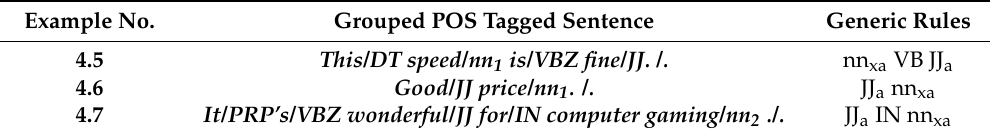
Table 5. Assignment of grouped POS tagged sentences to generic rules. Example No.